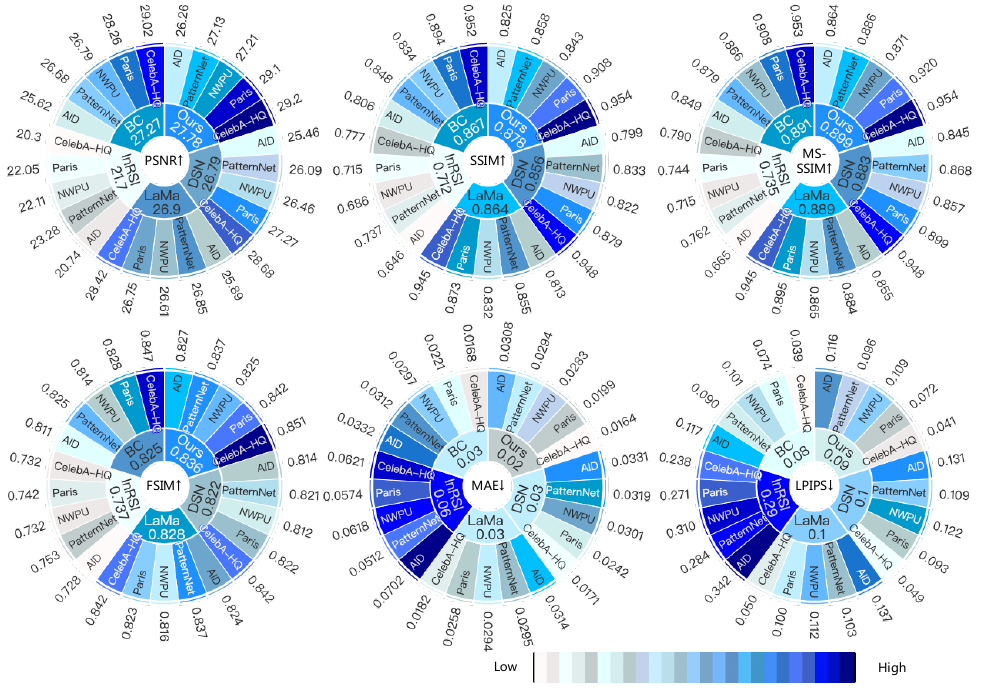
Figure 4. Overview of the statistical sunburst chart of the average performance for our AACNet on all datasets. The data used for this analysis were obtained from the AVG values in Tables 4 and 5. The higher values of PSNR, SSIM, MS-SSIM, and FSIM showed a better performance. The lower values of MAE and LPIPS showed a better